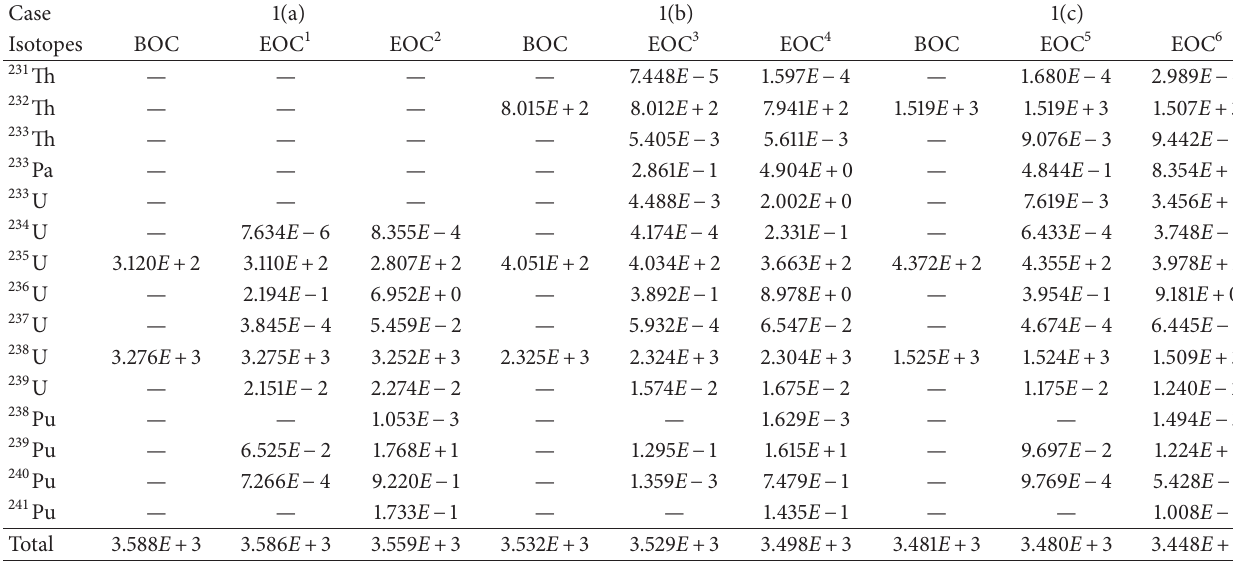
Table 6: Masses of actinide isotopes [kgHM] at the beginning and at the end of the cycle (Cases